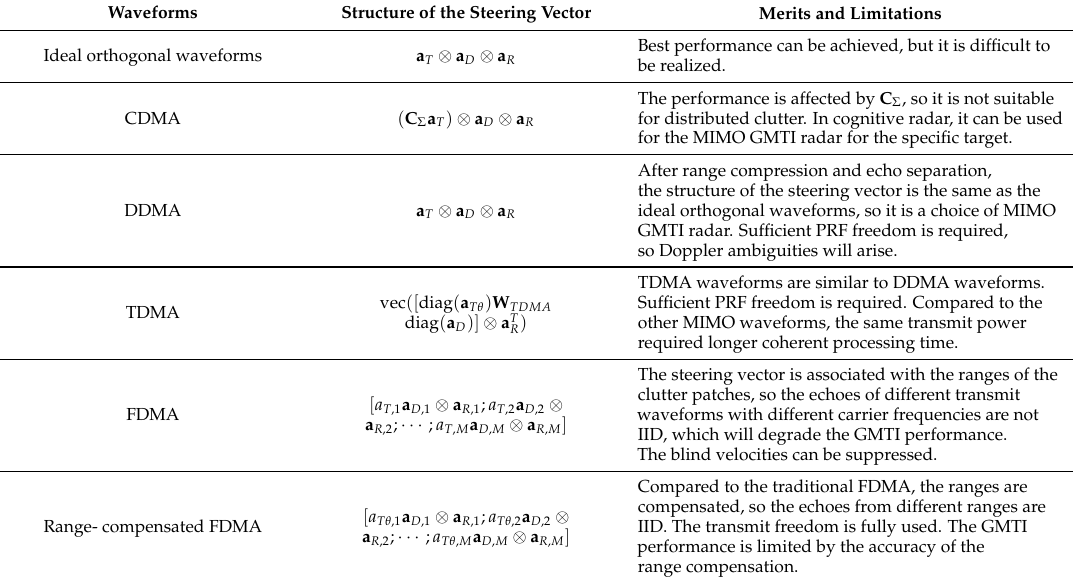
Table 3. The comparison of MIMO GMTI radar